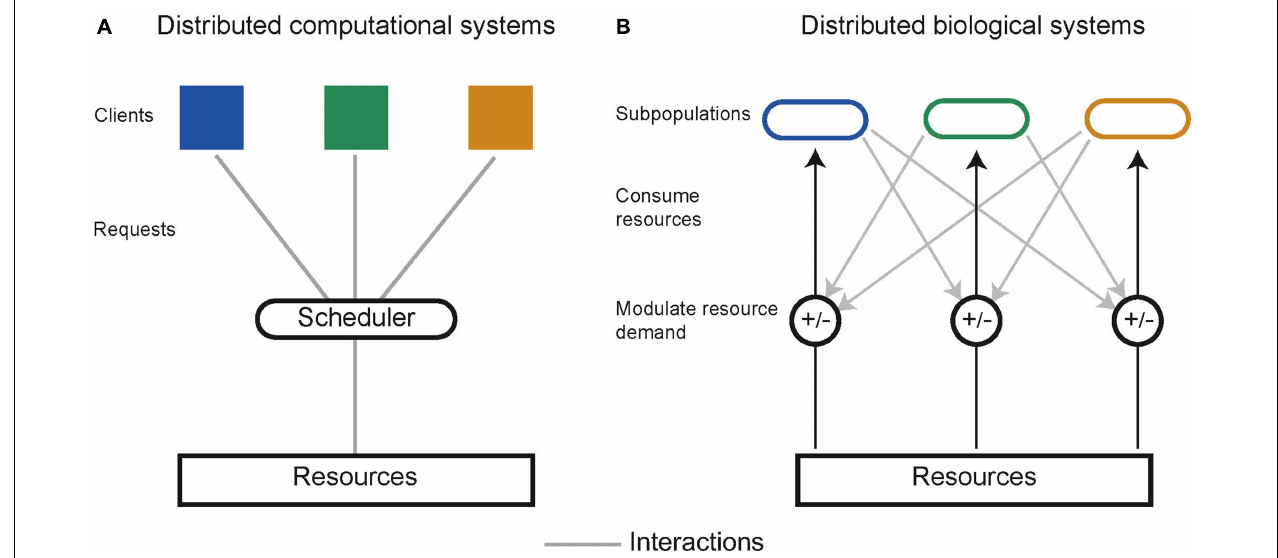
FIGURE 5 | (A) Schematic of resource allocation in distributed computational systems. Tasks communicate with a central scheduler which in turn allocates resources to tasks. (B) Resource allocation in distributed biological systems is decentralized. Subpopulations communicate and interact with one another to modulate the demand for resources, which can optimally allocate resources and prevent competitive exclusion.